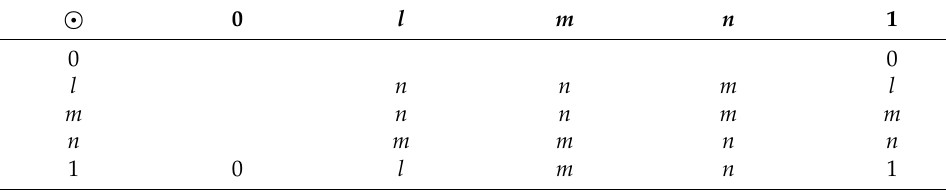
Figure 3. Lattice order relation on L . Table 5. The partial operation (cid:12) .